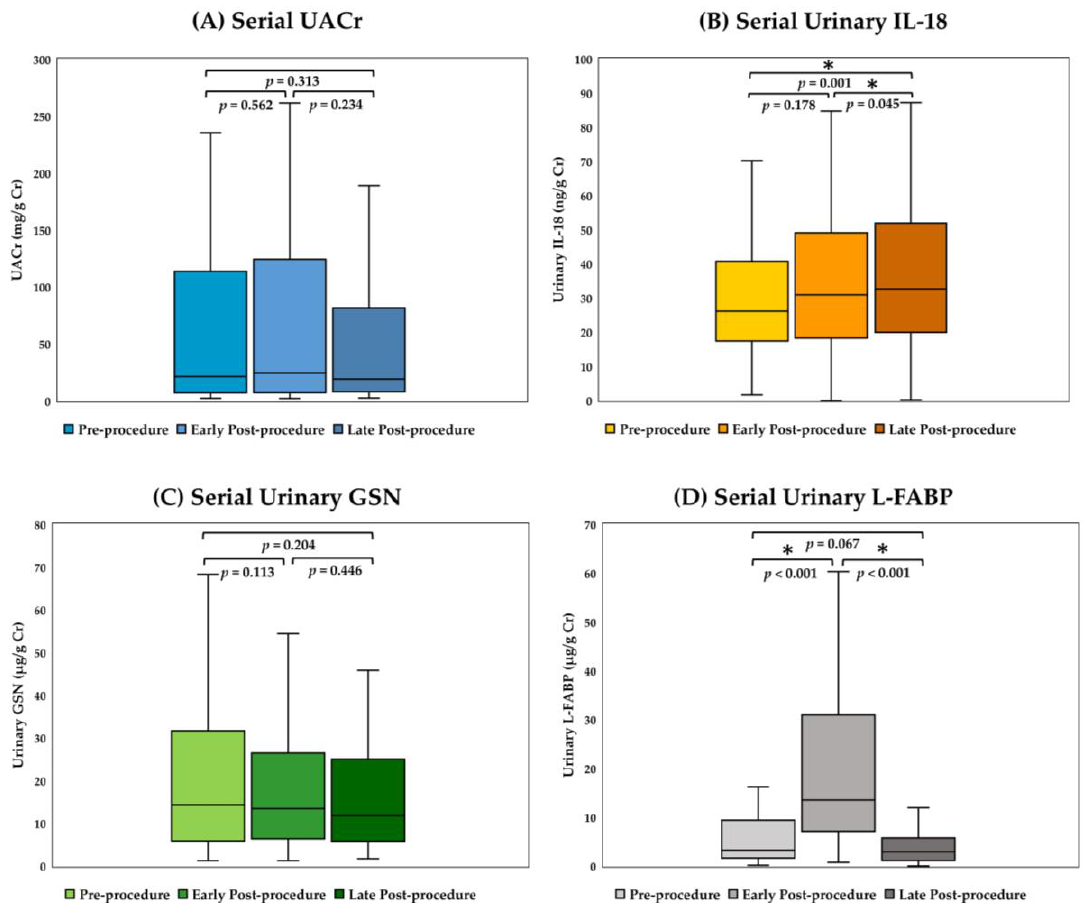
Figure 1. Patterns of Serial Urinary Biomarkers after Cardiac Catheterization. ( A ) Serial UACr; ( B ) serial urinary IL-18; ( C ) serial urinary GSN; ( D ) serial urinary L-FABP. The urinary biomarker levels during the pre-procedure, early post-procedure (12–24 h), and late post-procedure (7–10